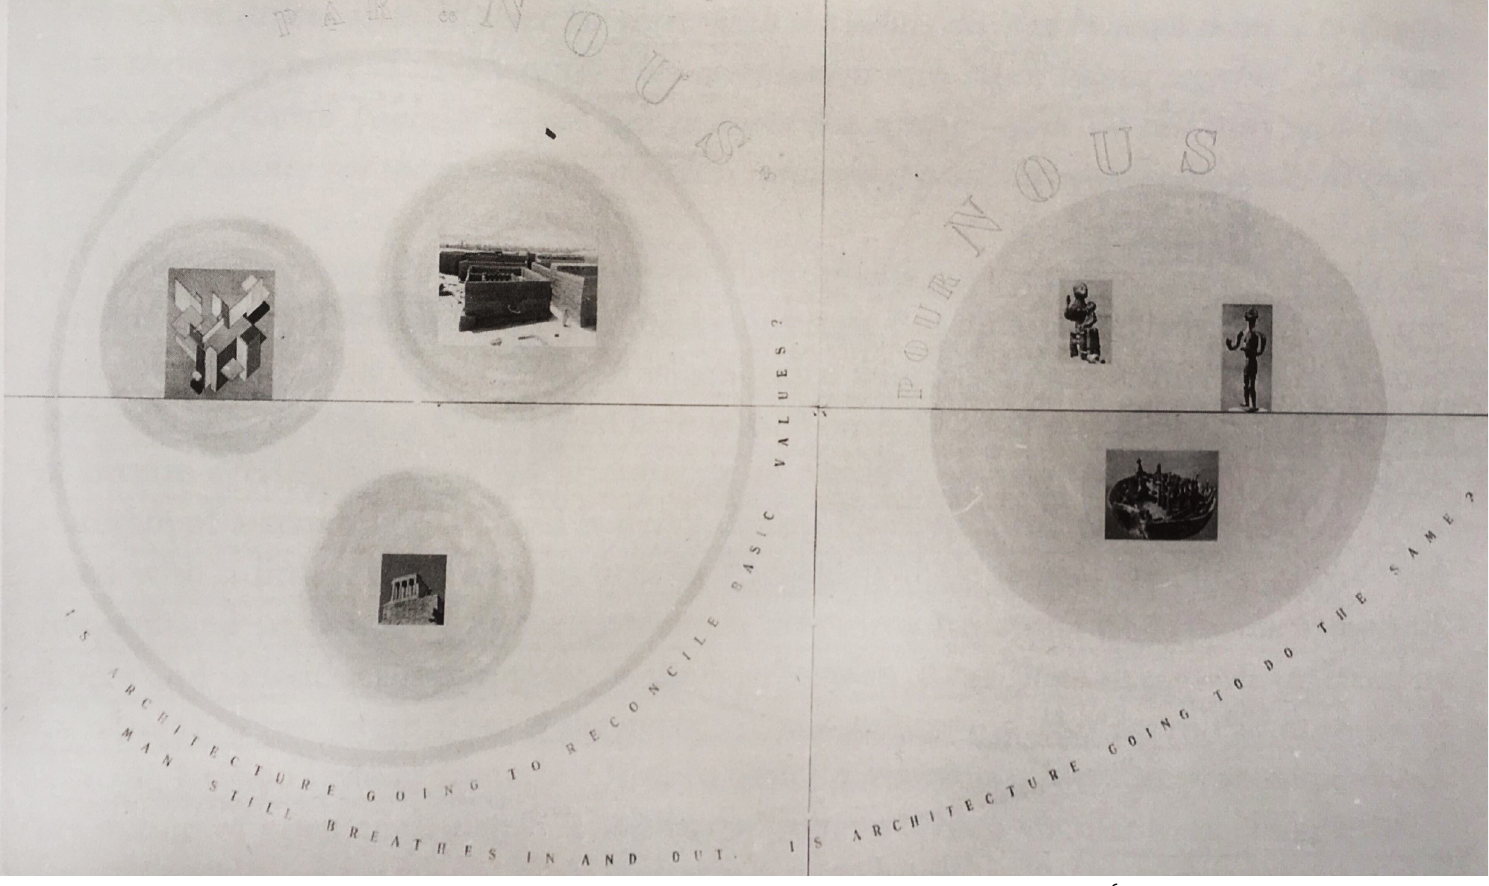
Fig. 6 “Otterlo Circles”, first version